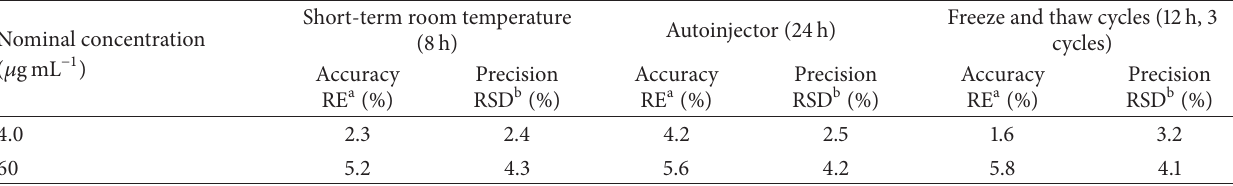
Table 6: Stability assays ( 𝑛 = 4 ) of the developed